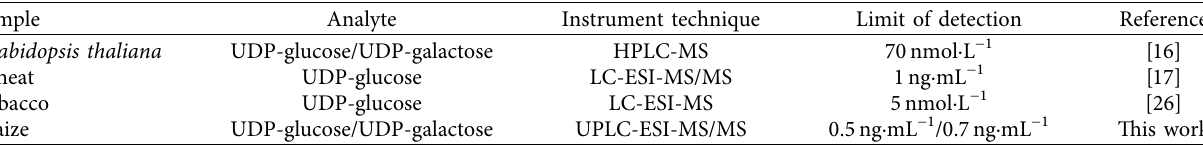
Table 5: Comparison of different analytical methods for the determination of UDP-galactose and UDP-glucose in plant samples. Sample